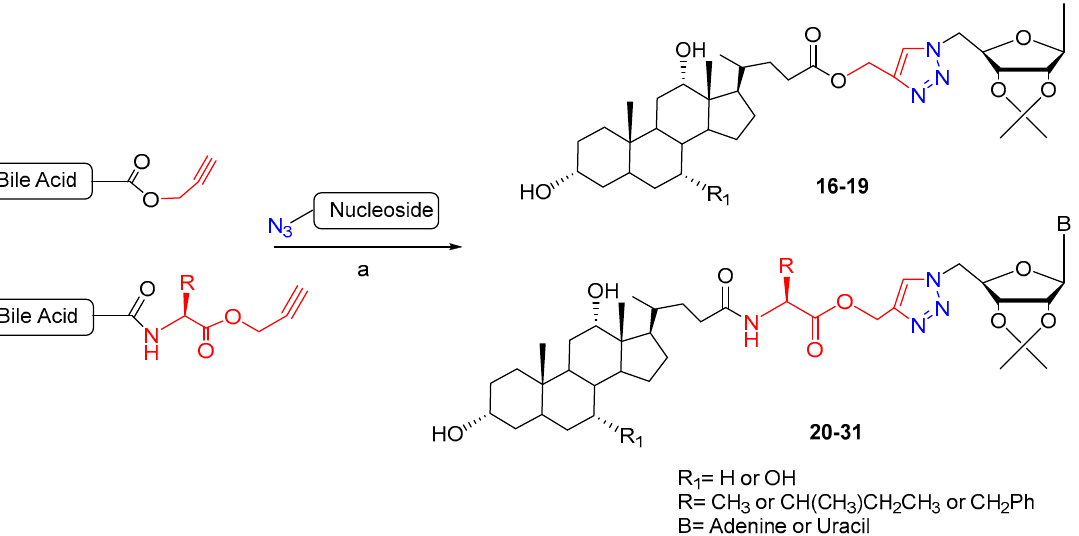
Table 2. In vitro anticancer activity evaluation of 16 – 31 by MTT